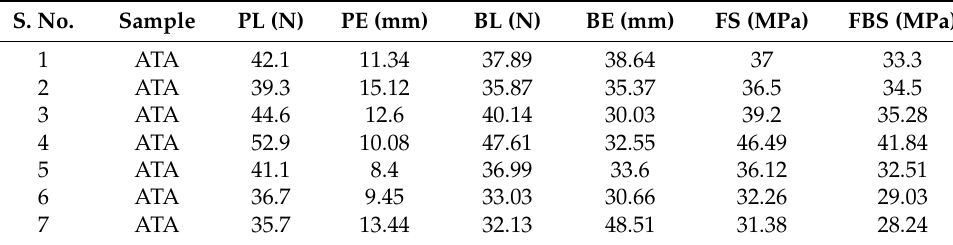
Table 5. Flexural testing results for ATA (ABS: TPU: ABS) specimens. S. No.